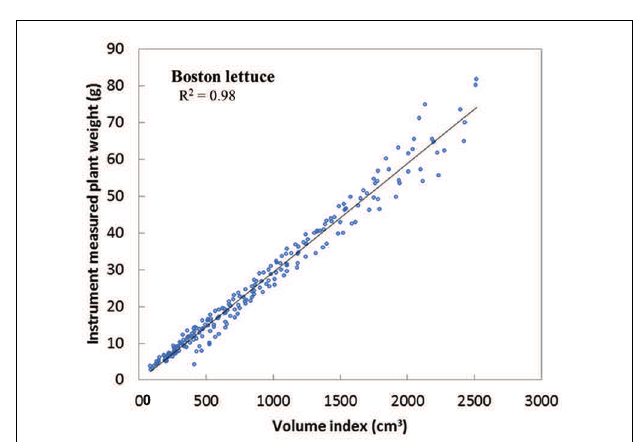
FIGURE 8 | Linear model built between plant weight and plant volume